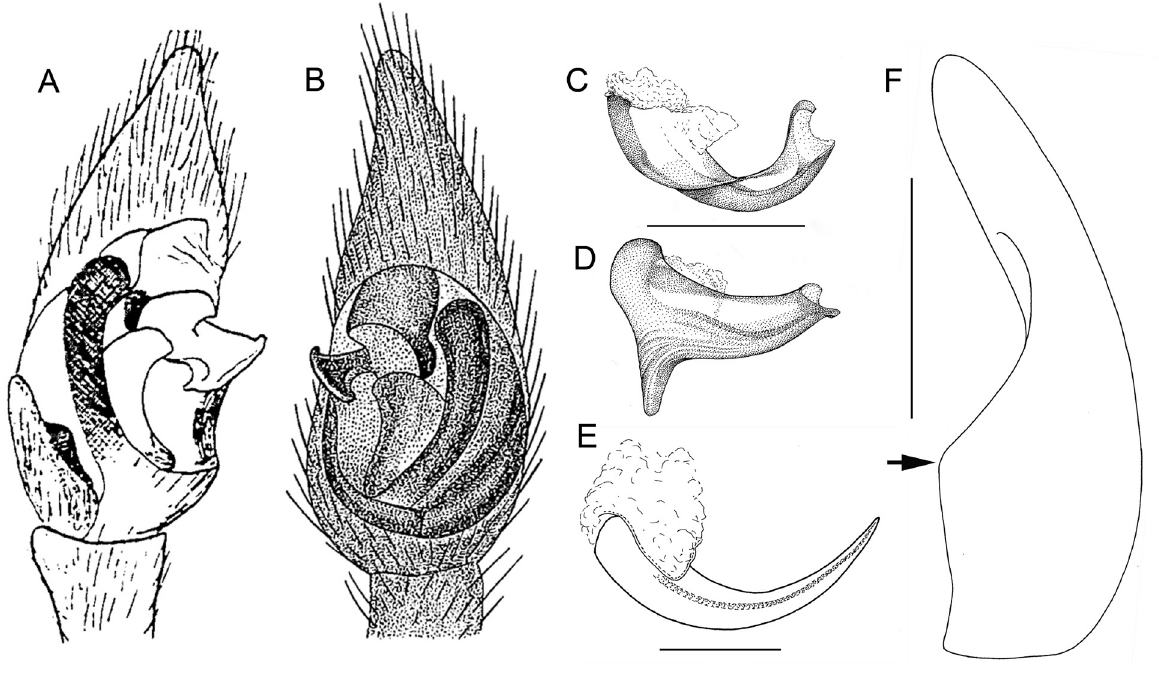
Fig. 2. — A – D . Wadicosa benadira (Caporiacco). A . Left male palp, from Caporiacco (1940: fig. 1). B . Right male palp, from Roewer (1959: fig. 18). C – D . Left embolus in ♂ from Kenya, Marsabit; anterior (C) and ventral (D) view. — E – F . W. jocquei sp. nov. Left embolus (E), frontal view, and left cymbium (F) in ♂ from Comoros, Anjouan. Arrow points at projecting retrolateral rim of cymbium. Scale bars: C–E = 0.2mm, F = 0.5